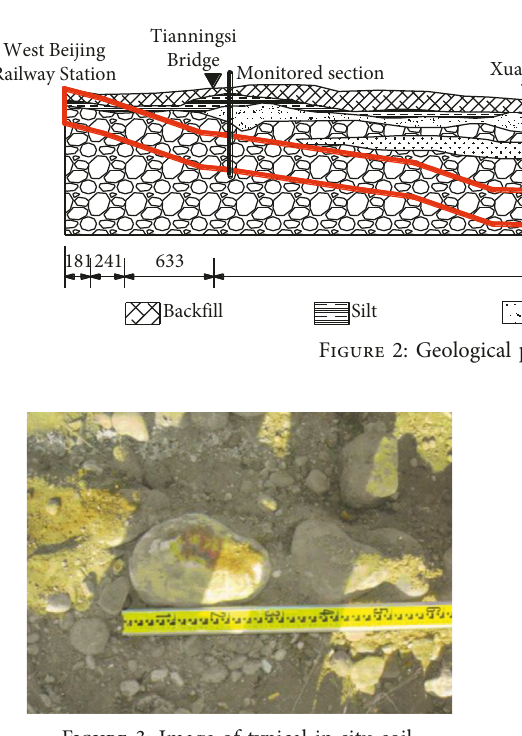
Figure 3: Image of typical in situ soil.